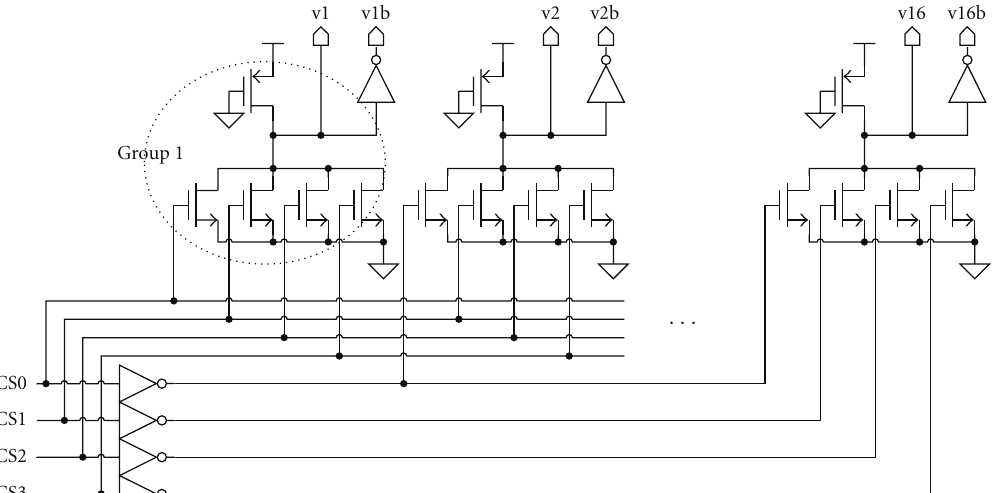
Figure 13: Simplified 4-bit encoder